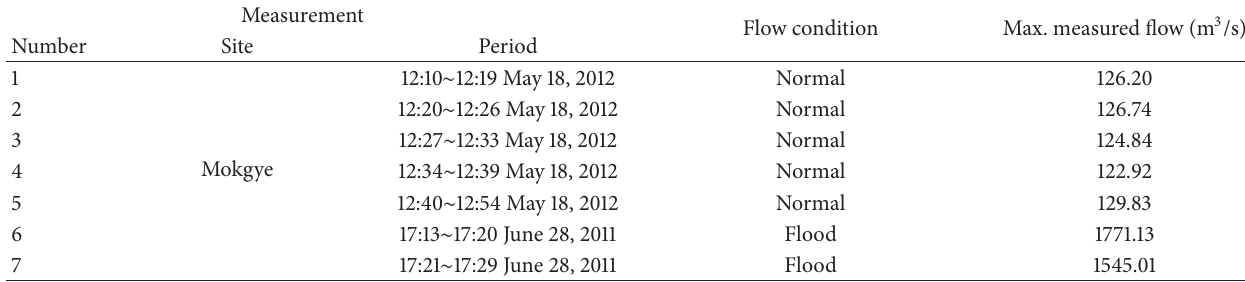
Table 4: Discharge measurements in this study.